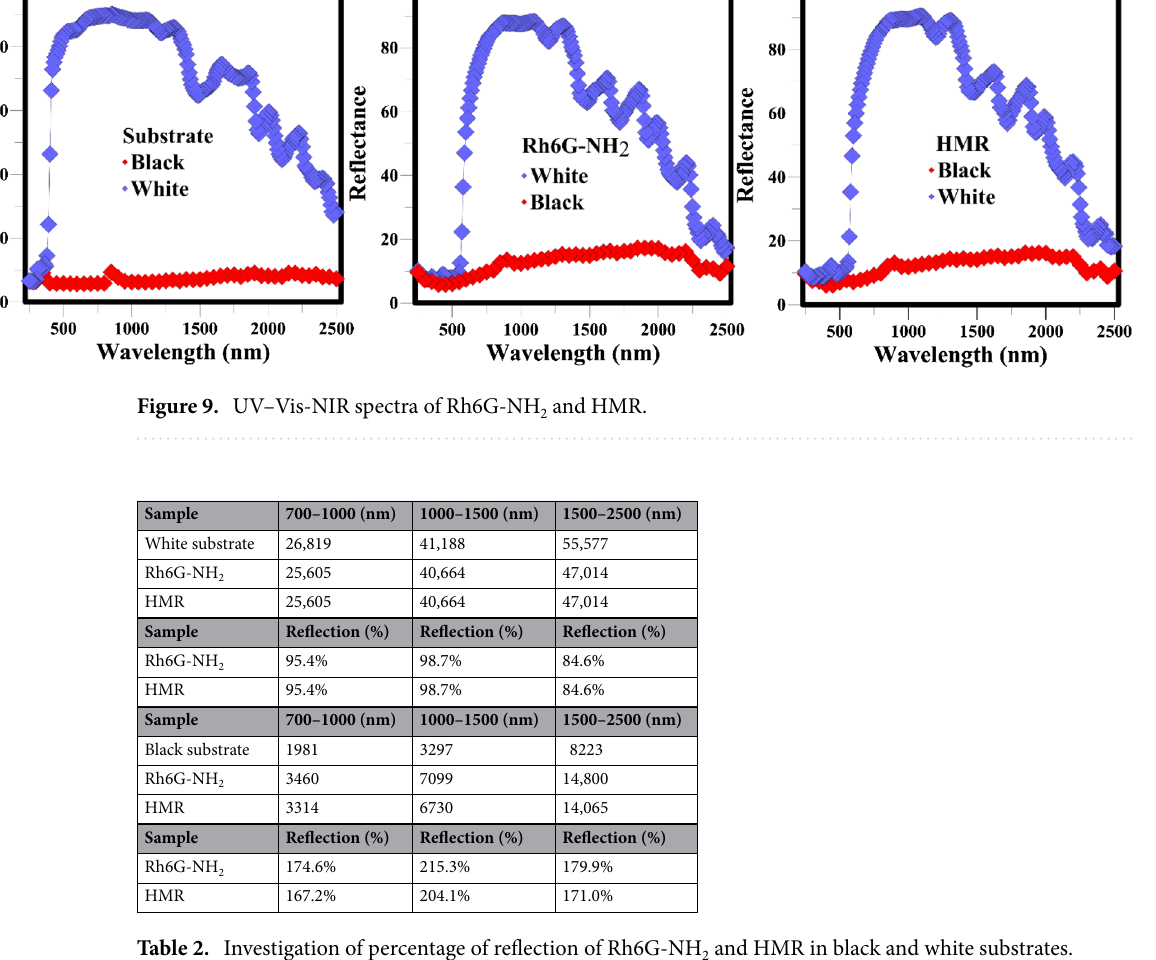
Table 2. Investigation of percentage of reflection of Rh6G-NH 2 and HMR in black and white substrates.